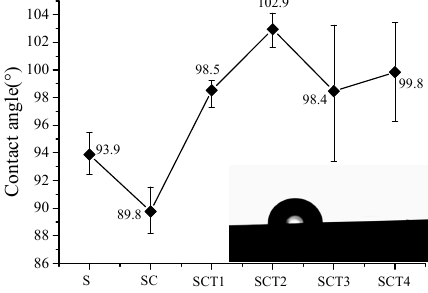
Figure 7. Contact angles of water on the surface of all samples.